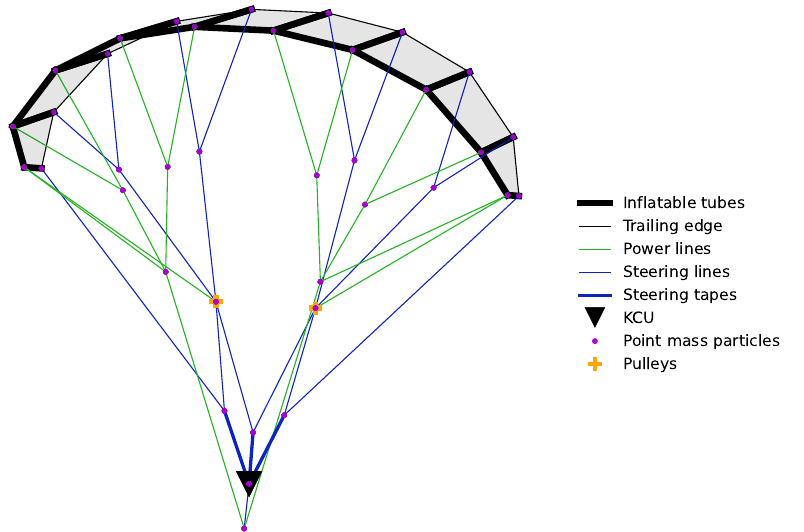
Figure 3. Particle-system representation of the LEI V3 kite